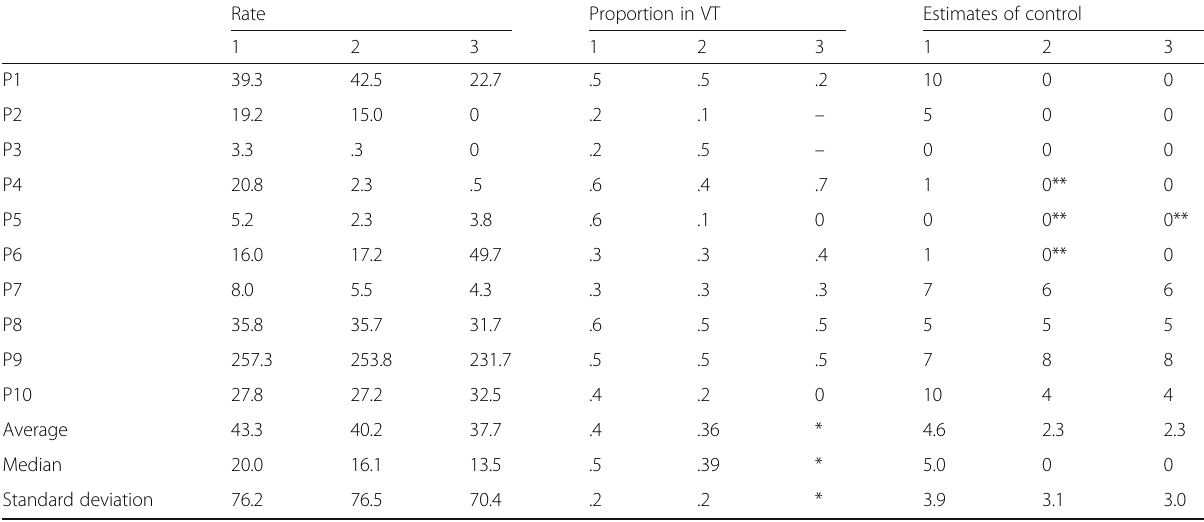
Table 1 Response rate, proportion of responses in the VT component, and estimates of control for all participants in the Individual Exposure condition (sessions 1, 2 and 3)